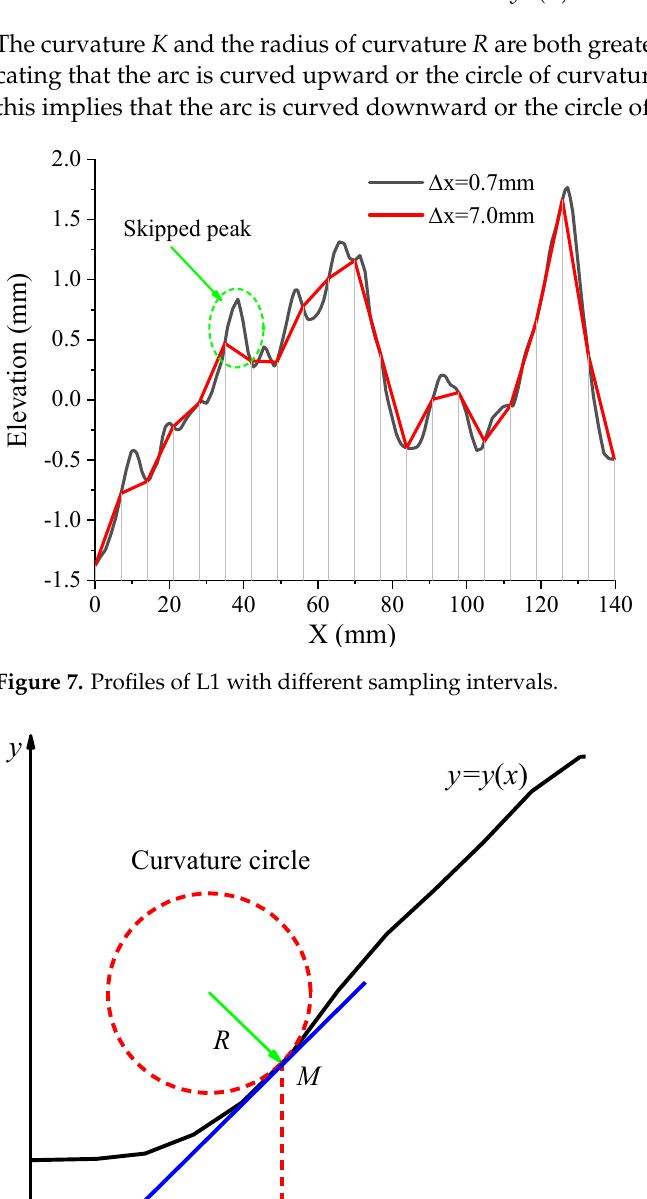
Figure 8. Curvature radius of point M on the profile line.